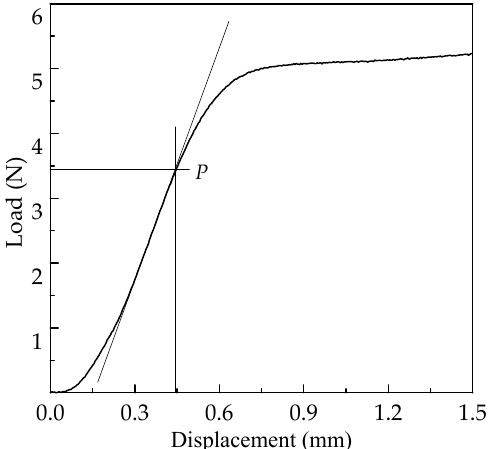
Figure 5. Method used to obtain proportional limit load ( P ).